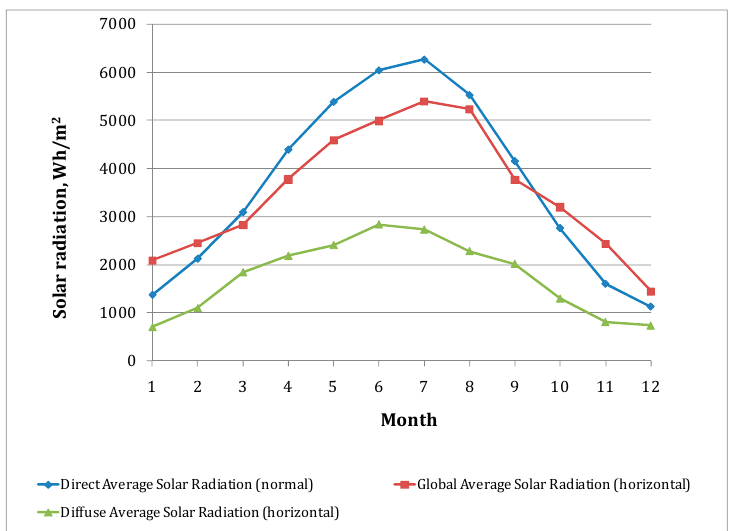
Figure 5. Solar radiation for Belgrade, from EnergyPlus weather file.